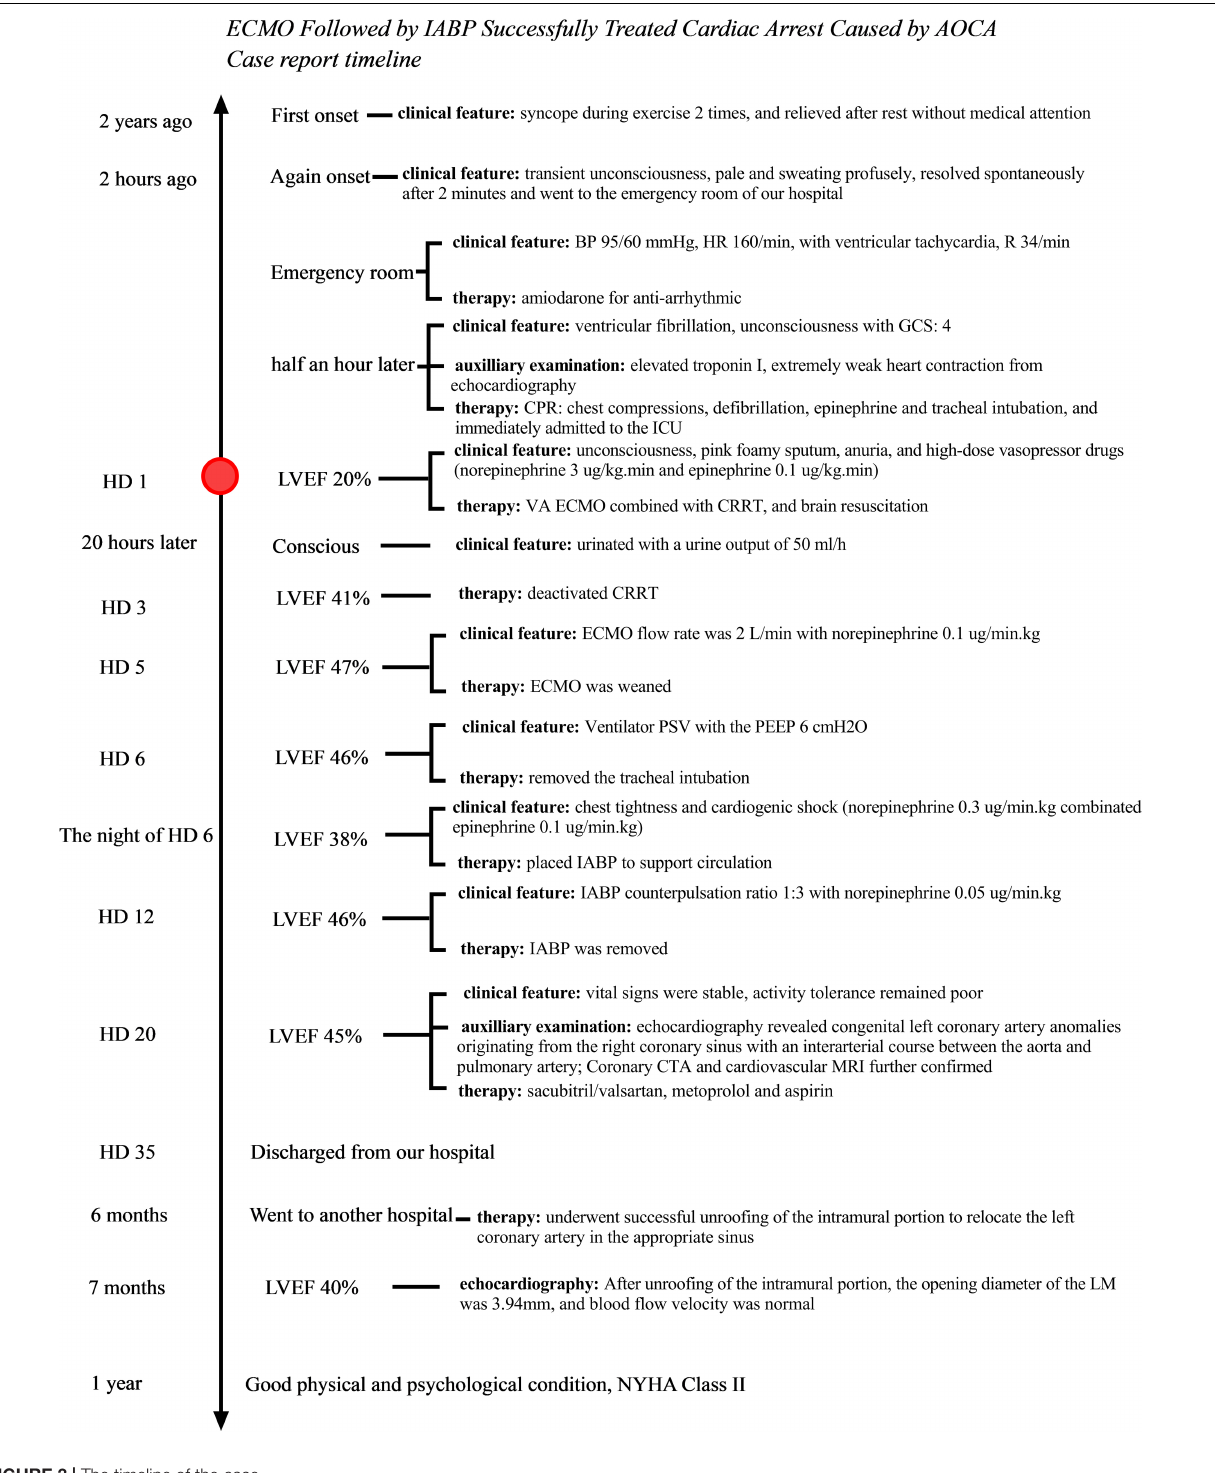
FIGURE 3 | The timeline of the case.